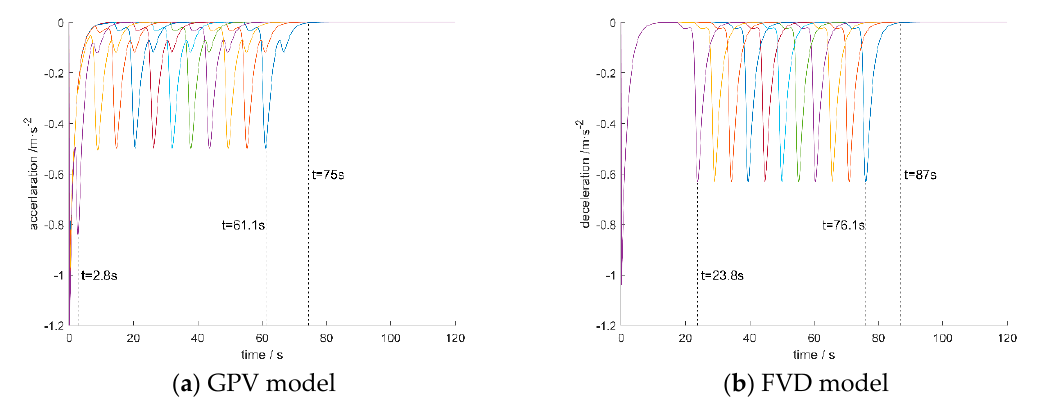
Figure 9. Comparison of deceleration during the braking process between the two models.